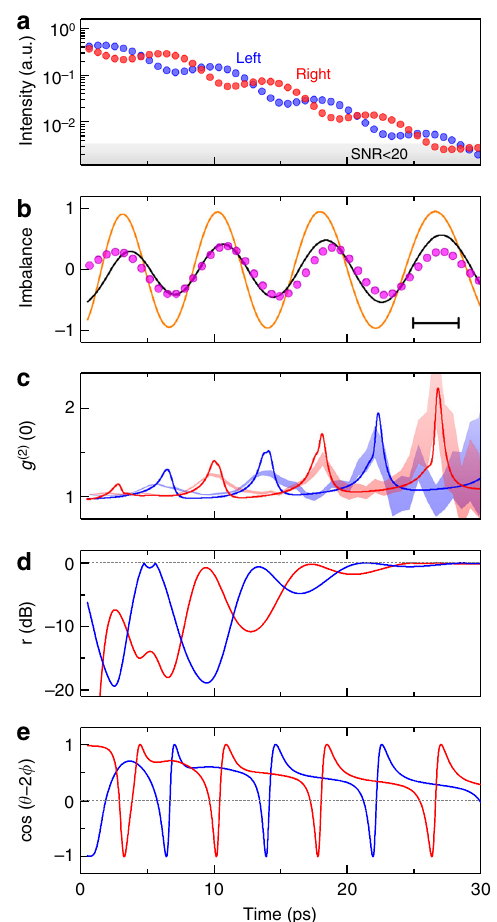
Fig. 2 Dynamical photon bunching. a Measured intensity of the light emission from the left (blue) and right (red) mesa. The gray area indicates the region where signal-to-noise ratio (SNR) is insuf fi cient for con fi dent correlation measurements. b Measured population imbalance between two mesas (magenta points) clearly reveals the Josephson oscillations. Results of simulations (orange) match well the measured imbalance when convoluted with the Gaussian corresponding to the time resolution of the streak-camera being 3.4 ps (black). Time resolution is given in the plot. c Second-order correlation function g (2) (0) of the light emission from the left (blue shaded) and right (red shaded) mesa shows that the light statistics changes from Poissonian ( g (2) (0) = 1) to bunched ( g (2) (0) > 1) in phase with Josephson oscillations. Shaded areas represent the error bars calculated as the standard errors of the mean values. The corresponding results of the theoretical simulations are shown with blue and red lines. d , e Simulated evolution of d the absolute value of the squeezing magnitude, and e the cosine term from Eq. (3) for the left (blue) and right (red)